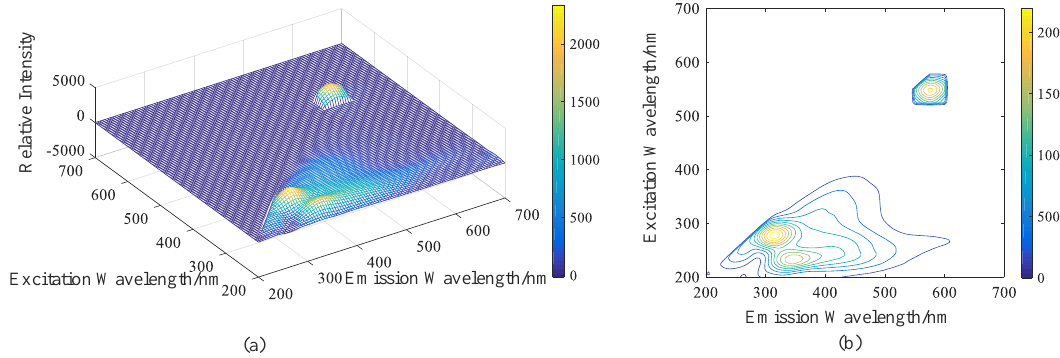
Figure 10. 3D ( a ) and contour ( b ) diagrams of 4 μg/L rhodamine B positioning result.